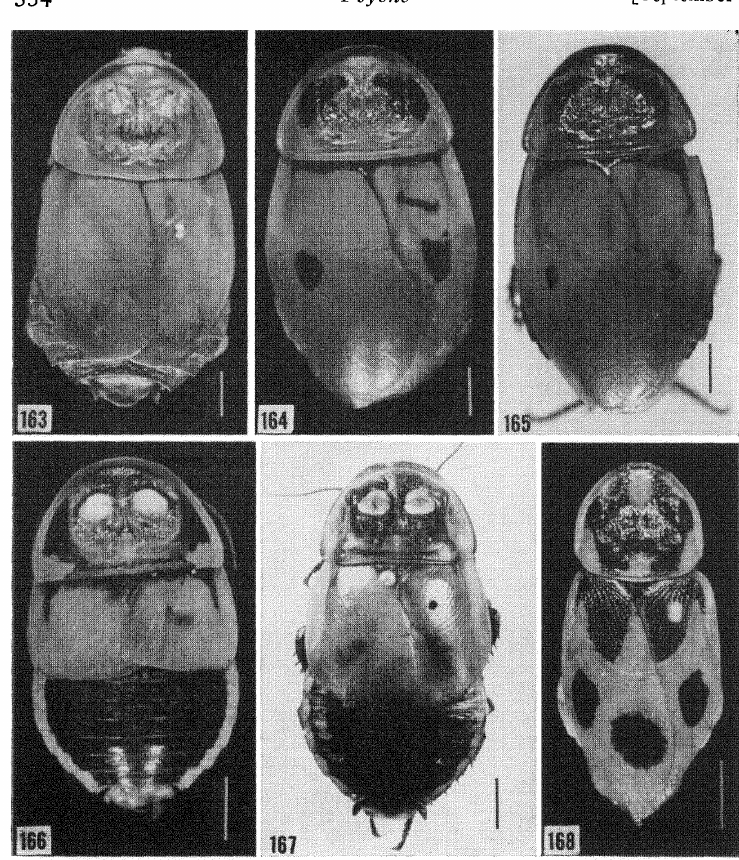
Figs. 163-168. 163. (1 ANSP). Hormetica laeigata Burmeister. So Paulo, Brazil (det. Rehn). 164. (2 ANSP). Horrnetica apolinari Hebard. Susumuco, Colombia (det. Hebard). 165. (14 MCZ). Hormetica apolinari. Villavicencio, Colombia (det. Roth). 166. (4 ANSP). Hormetica sub- clncta (Walker). Villavicencio, Colombia (det. Hebard). 167. (44 CUZM). Hormetlca qaerrucosa Brunner. Colombia. 168. (5 ANSP). Brachycola sexnotata (Thunberg). 92 Km from Rio de Janelro, Brazil (det. Rehn). (scale